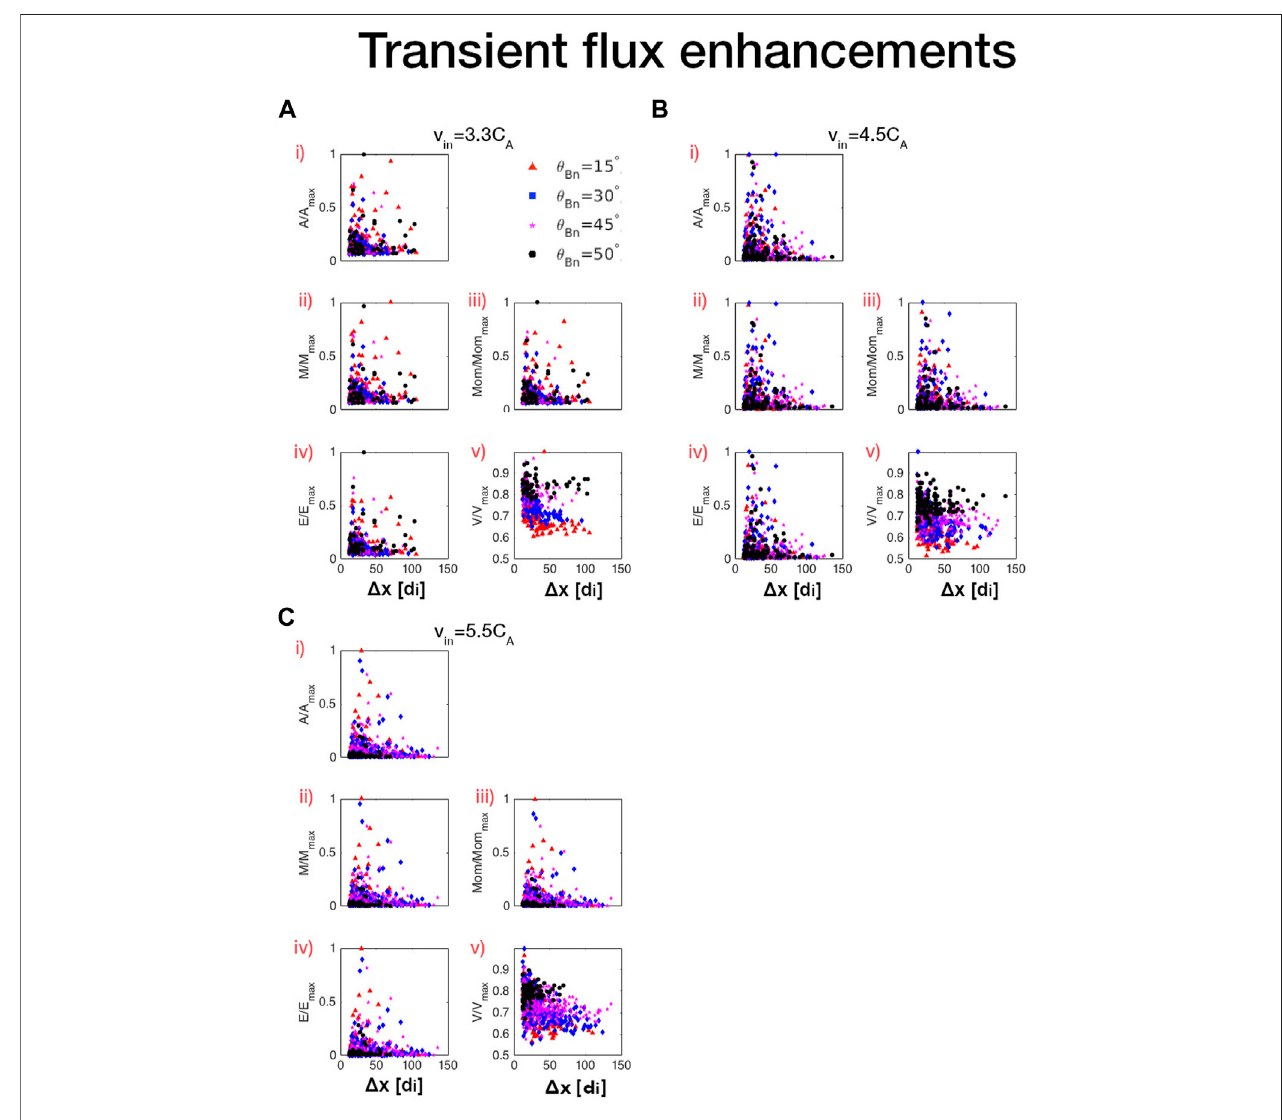
FIGURE 8 | Scatter plots of properties of transient fl ux enhancements as a function of their distance from the shock. The format is the same as in Figure 7 .